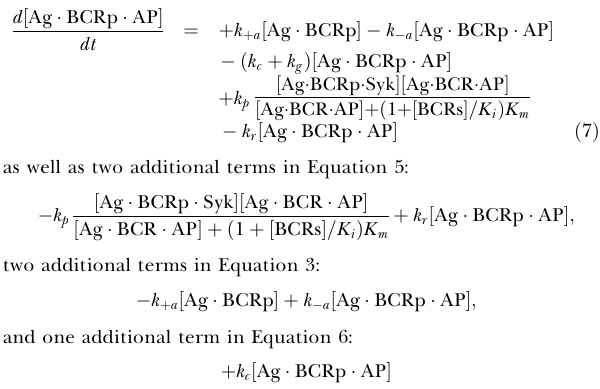
Figure S1. Knockdown of BLNK in A20IIA1.6 Cells (A) Total cell lysates from cells expressing a BLNK specific shRNA, or vector alone, were immunoblotted with anti-BLNK and anti-Ig a antibodies. (B) Indicated cells were stimulated with anti-IgG for 3 min and total cell lysates immunblotted with anti-phosphotyrosine anti- bodies (4G10). Position of BLNK indicated (*). (C) Cells expressing indicated shRNA were stimulated with anti-IgG (3 min), lysed, and